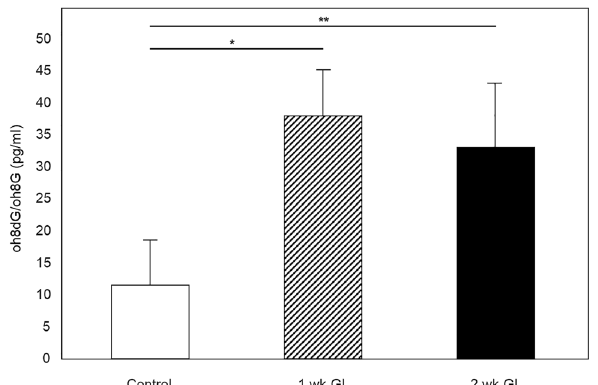
Figure 4. Quantitative analysis of oxidative damage to retinal mitochondrial DNA/RNA after IOP elevation. The level of 8OHdG/8OHG in mitochondrial DNA/RNA samples was measured with DNA/RNA Oxidative Damage ELISA kit. Oxidative damage to mitochondrial DNA/RNA isolated from retinas of rats with 1 and 2 weeks of elevated IOP was approximately 3.2 (n = 6, * P = 0.006) and 2.8 (n = 8, ** P = 0.017) fold higher compared to controls (n = 12), respectively. Data are presented as the mean ± SD.